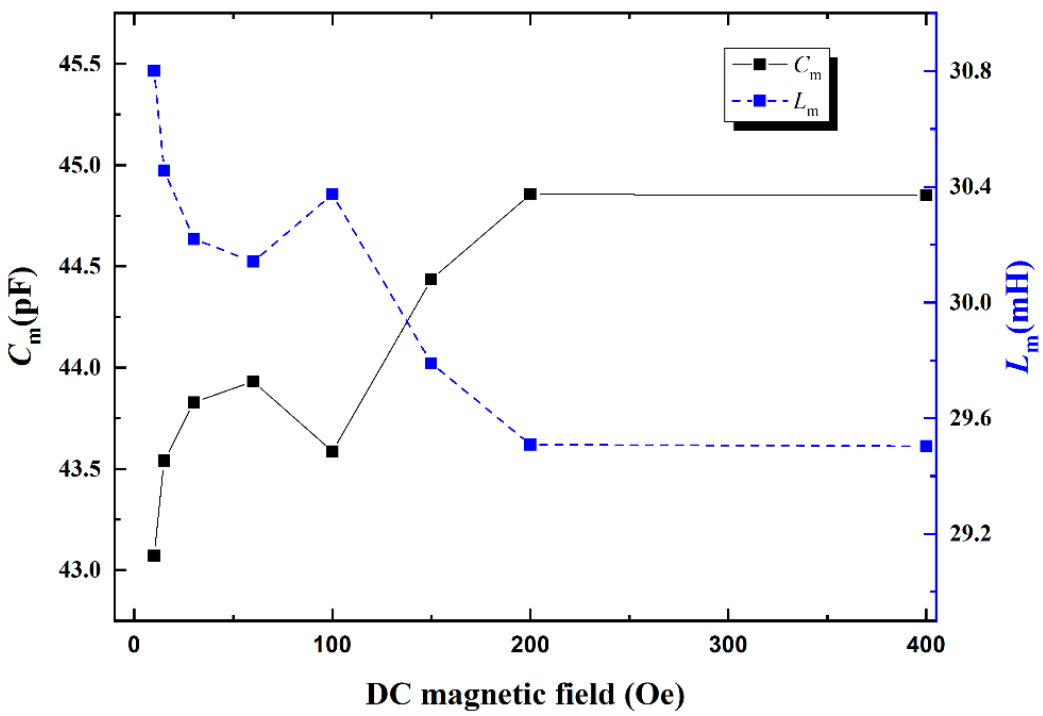
Figure 5. The C m and L m of the ME sensor as a function of DC magnetic field. Here, the maximum RSDs of C m and L m with multiple measurements are 0.23% and 0.25%, respectively.